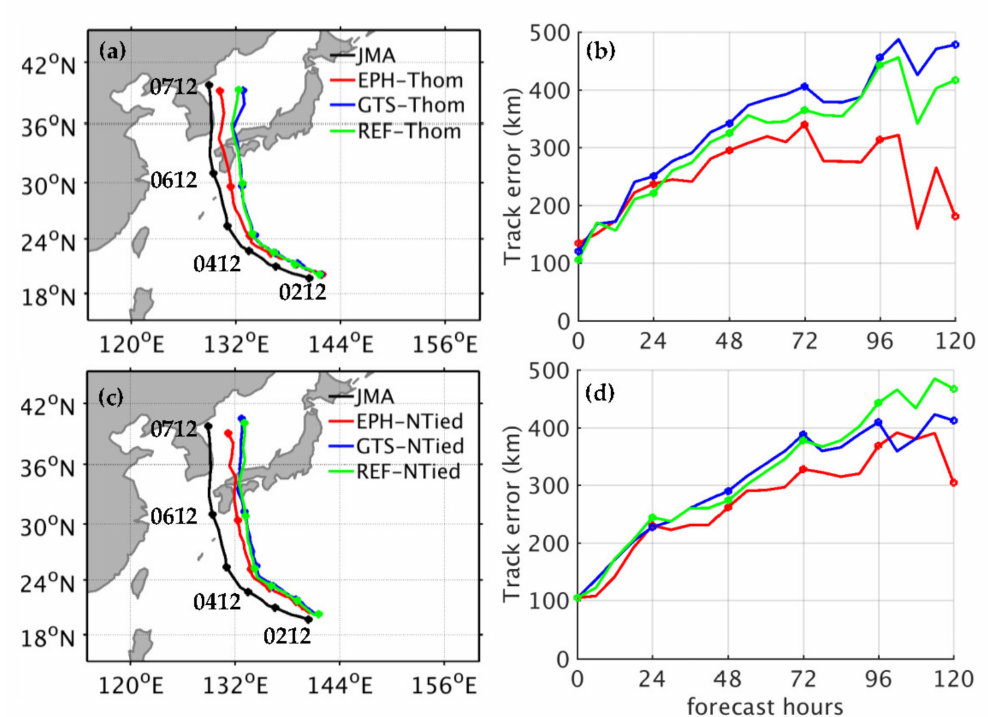
Figure 11. ( a ) Simulated tracks of Haishen for EPH-Thom (red line), GTS-Thom (blue line), and REF- Thom (green line) experiments and the best tracks of JMA (black line). The Thompson microphysics scheme was used in the three experiments. ( b ) as in ( a ) but for track error. ( c ) as in ( a ) but using the New Tiedtke cumulus parameterization. ( d ) as in ( c ) but for track error. Circle symbols in ( a , b ) mark the typhoon centers every 24